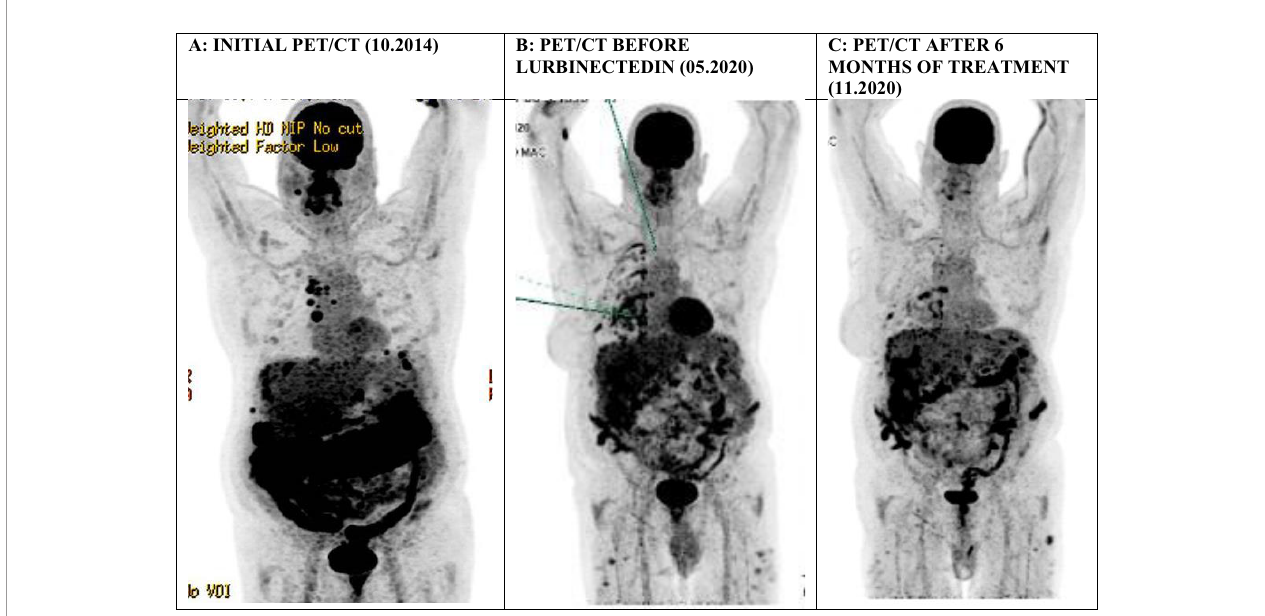
FIGURE 1 | A series of PET/CT scans (Maximum Intensity Projections) in the fi rst patient showing: (A) signs of peritoneal carcinomatosis in the subdiaphragmatic space in fi ltrating the large omentum and associated with ascites, in addition to supradiaphragmatic laterocervical and mediastinal lymphadenopathies, (B) persisting multiple peritoneal implant lesions at the time of treatment initiation, (C) a signi fi cant improvement of the previously described peritoneal lesions with an overall regression of their metabolic